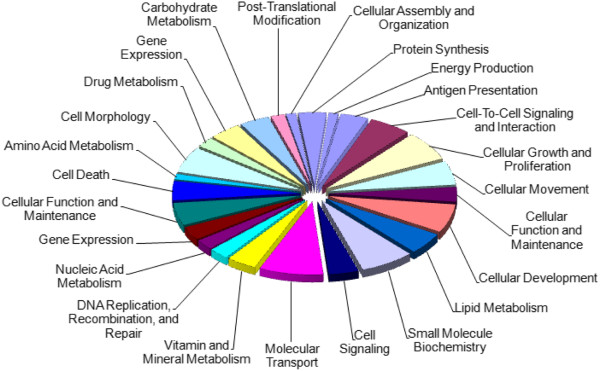
Molecular and cellular functions associated with genes down-regulated in lymphocytes in response to rapamycin treatment. The chart shows the number of genes, expressed as a percentage of the total number, involved in each of the molecular and cellular functions deemed significant by IPA Ingenuity.